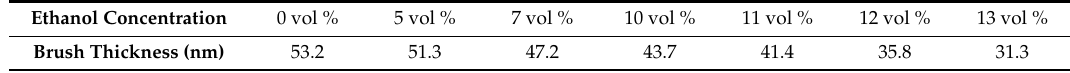
Table A1. Raw data of swollen brush thickness of a PNiPAAm brush plotted in Figure 1d.